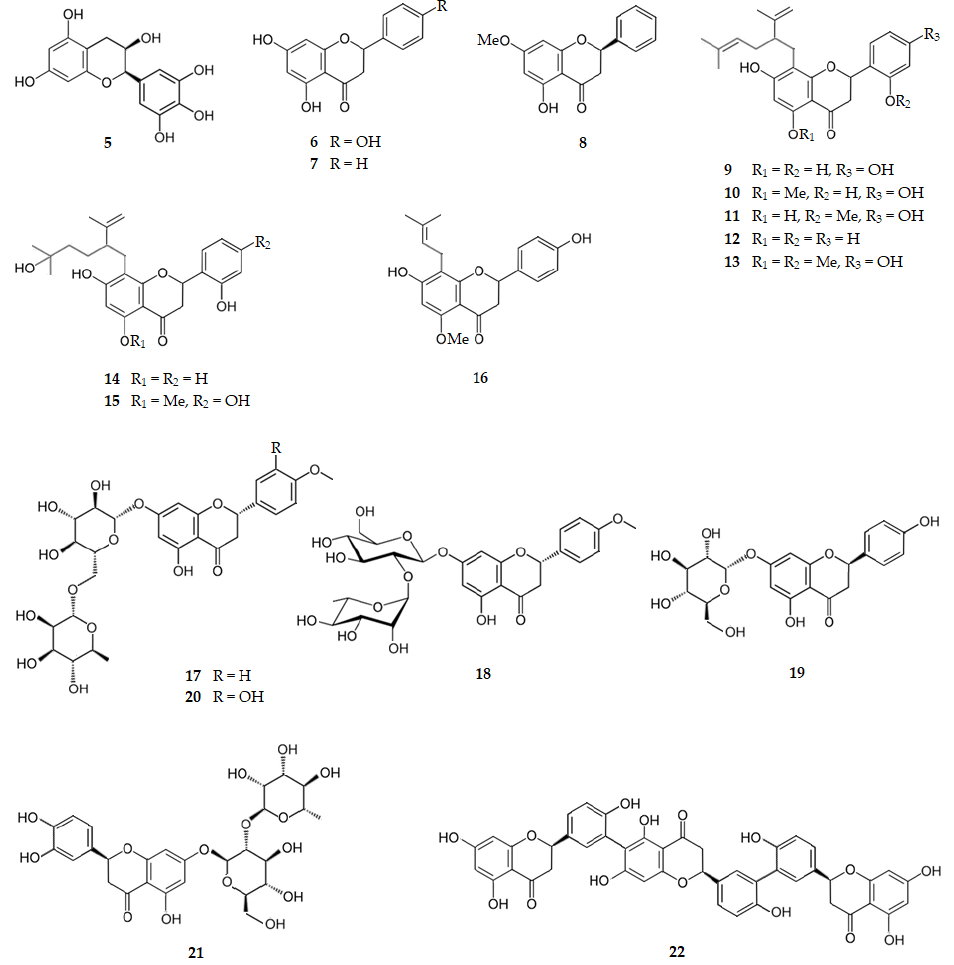
Figure 5. Structure of catechins and flavanones that inhibit β -secretase.